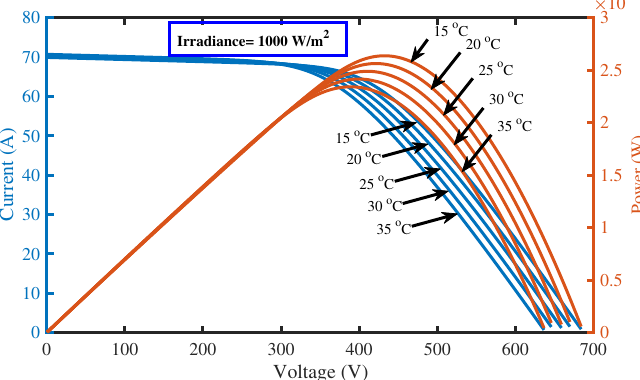
Figure 5. I-V and P-V characteristics for varying